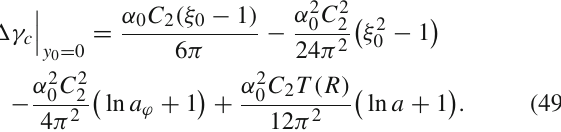
(cid:3) (cid:2) (cid:17)γ φ ji in Eq. (46) is a part of the matter The expression superfield anomalous dimension corresponding to the